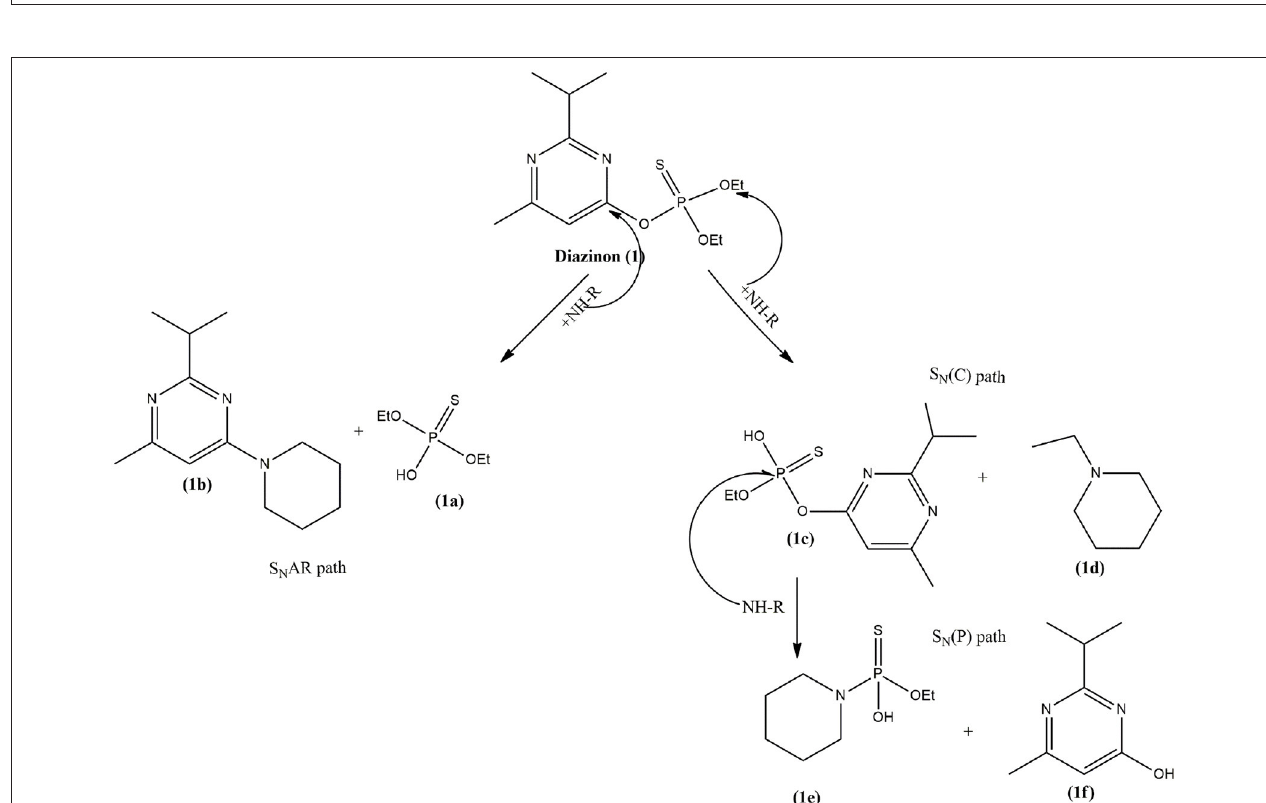
SCHEME 3 | Reaction pathway for degradation of 1 by piperidine in 1,3-Dioxolane, Dioxane and 2-MeTHF.